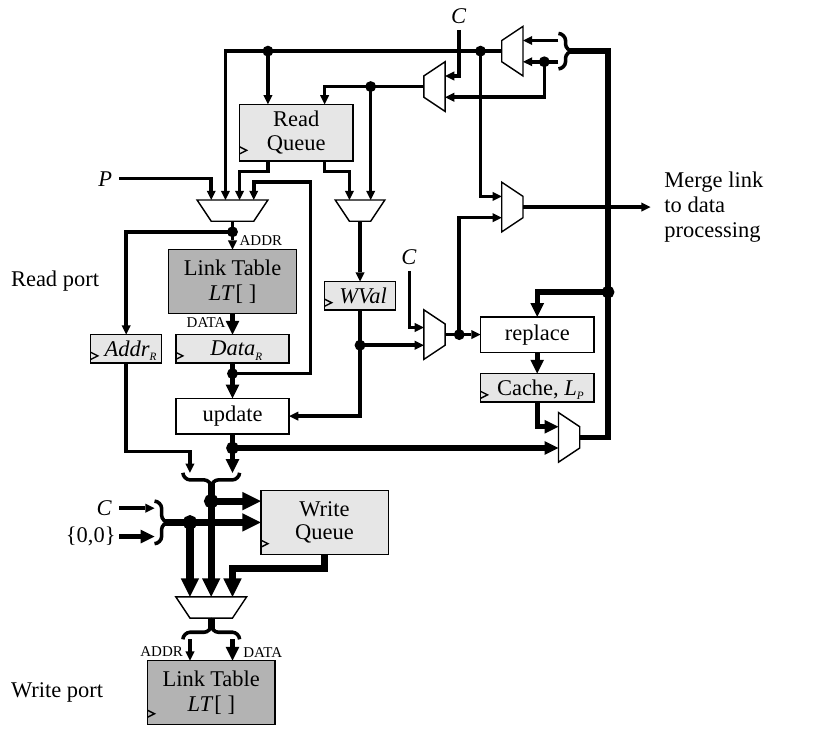
Figure 8. Detailed architecture of the link table processing. Only the data path is shown. The thickness of the lines represents the width of the data path (whether 1, 2, or 3